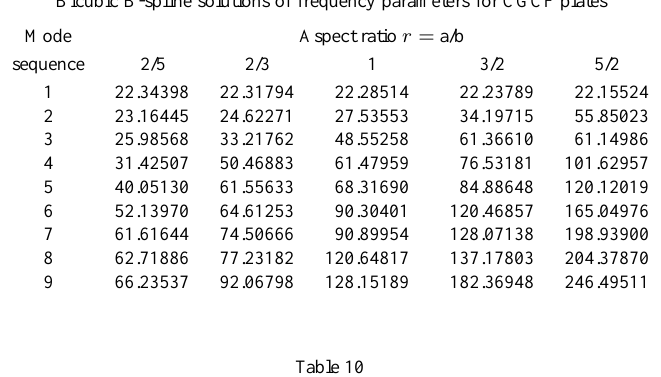
Table 9 Bicubic B-spline solutions of frequency parameters for CGCF plates